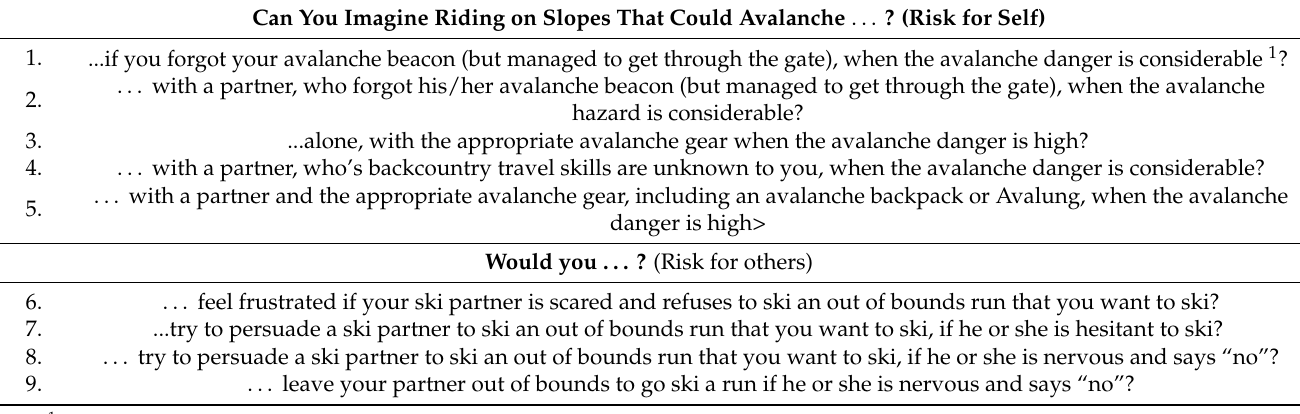
Table 6. Measures of intentions to engage in risky behavior in avalanche